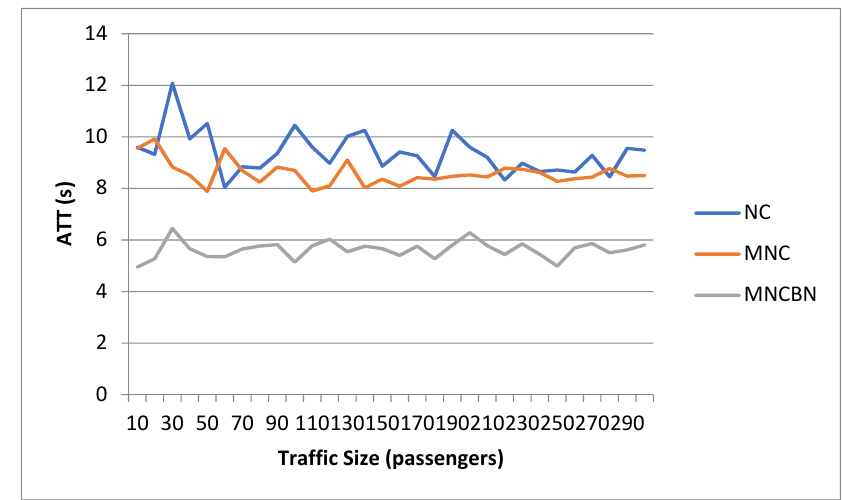
Figure 5. Dependence of average travel time (ATT) on change in traffic size.